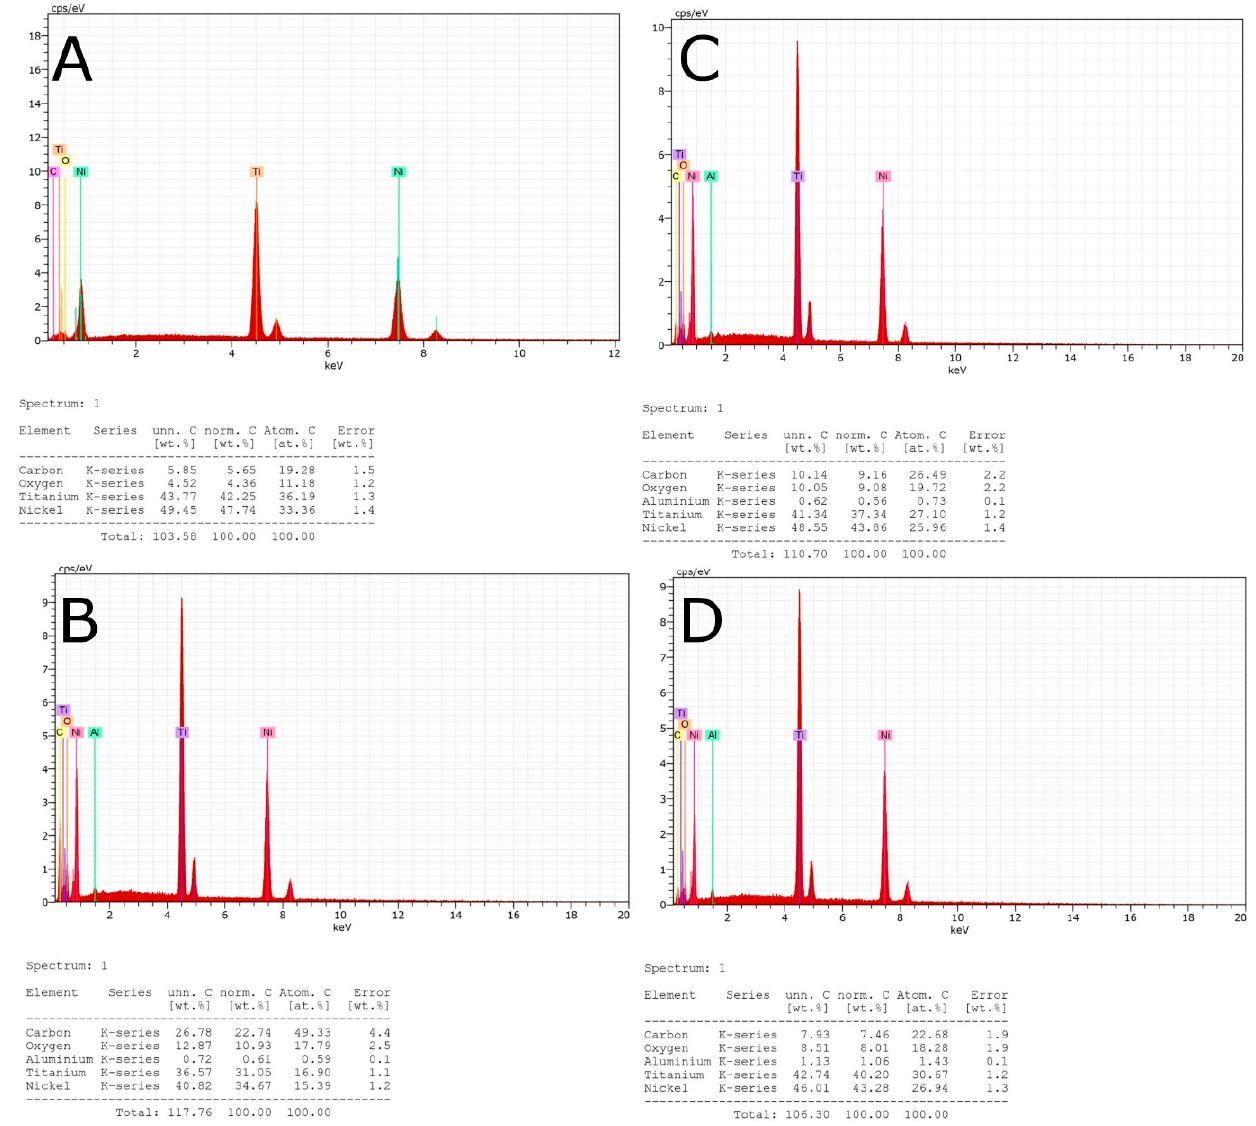
Figure 2. ( A ) EDX micro-analysis of the Mtwo NiTi alloy endodontic rotary file, ( B ) T Pro E1 austenite phase NiTi alloy endodontic rotary file, ( C ) T Pro E2 austenite phase NiTi alloy endodontic rotary file, and ( D ) T Pro E4 austenite phase NiTi alloy endodontic rotary file.